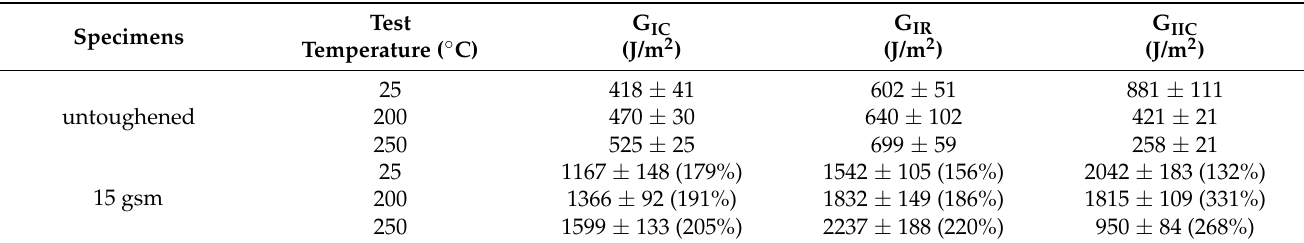
Table 2. The results of DCB and ENF tests for the untoughened laminate and the 15 gsm fiber veils interleaved laminate measured at different temperatures. The values in brackets represent the percentage increase of G I and G IIC values over the untoughened specimen at the corresponding